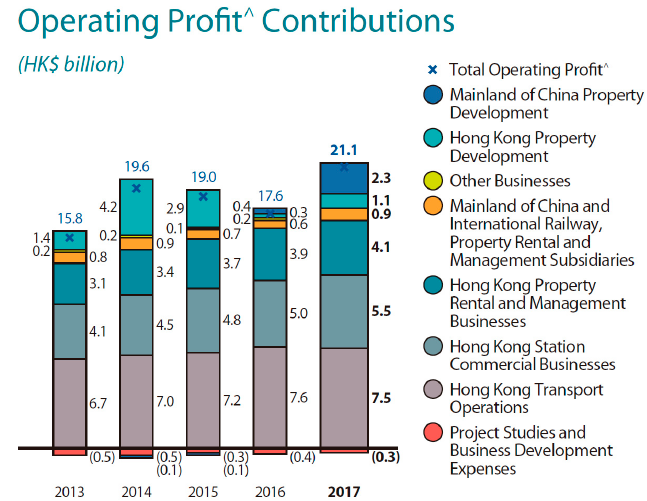
Figure 3. Hong Kong MTR Corporation operating profit. Source: MTR Corporation [48].